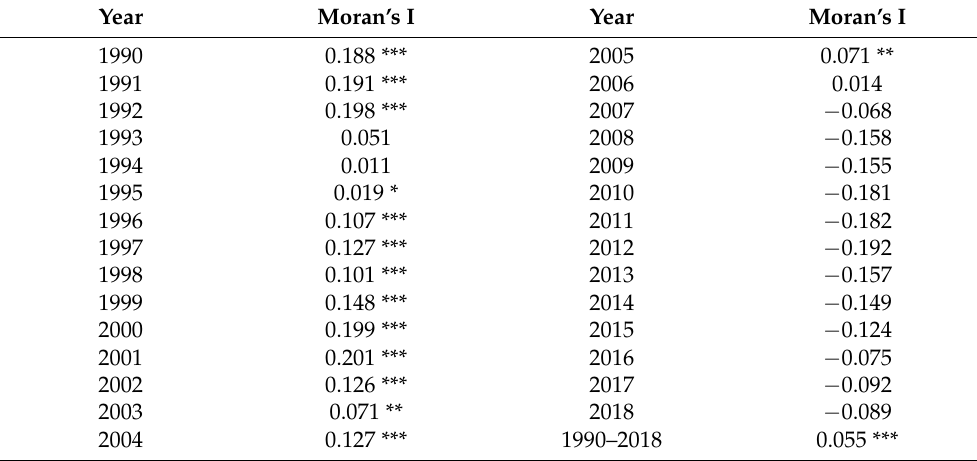
Table 2. Bivariate global Moran’s